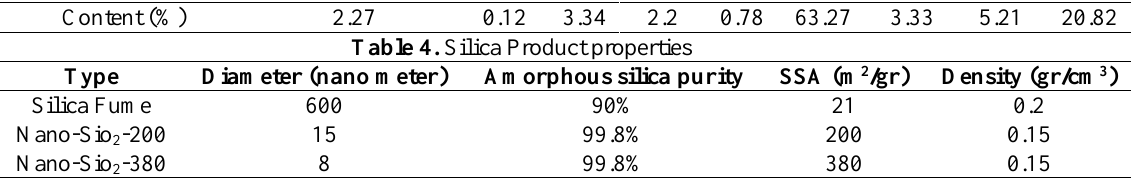
Table 4. Silica Product